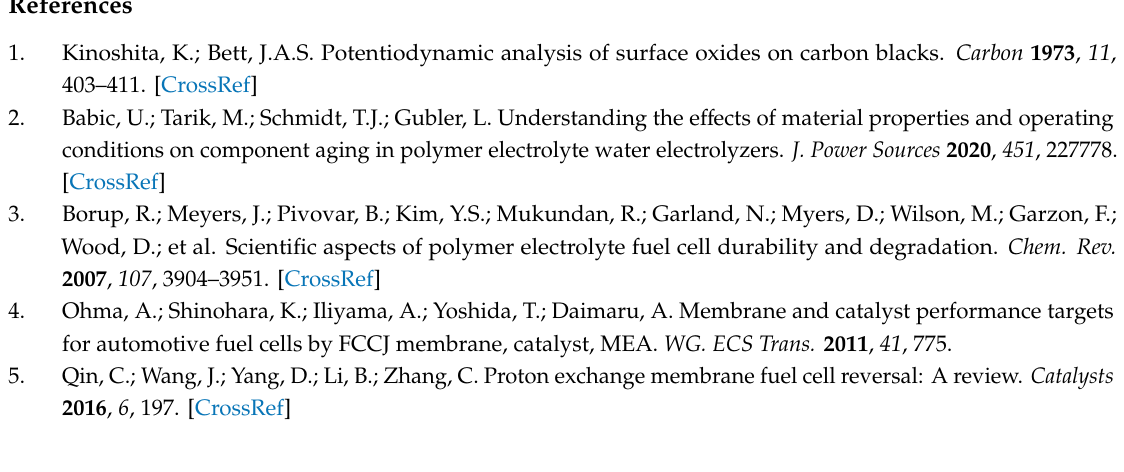
Supplementary Materials: The following are available online. Figure S1: Thermogravimetric (TG) analyses of porous Pt (a) with heat treatment at 400 ◦ C for 3 h under dry nitrogen and (b) with additional heat treatment at 200 ◦ C for 10 min under humidified nitrogen, Figure S2: SEM images of (a) porous Pt and (b) Pt black with a higher magnification, Figure S3: XRD patterns of porous Pt (top, red) and Pt black (bottom, blue), Figure S4: Cyclic voltammograms of porous Pt (red), Pt black (blue), and Pt / KB (black), where the current is normalized to specific surface area of